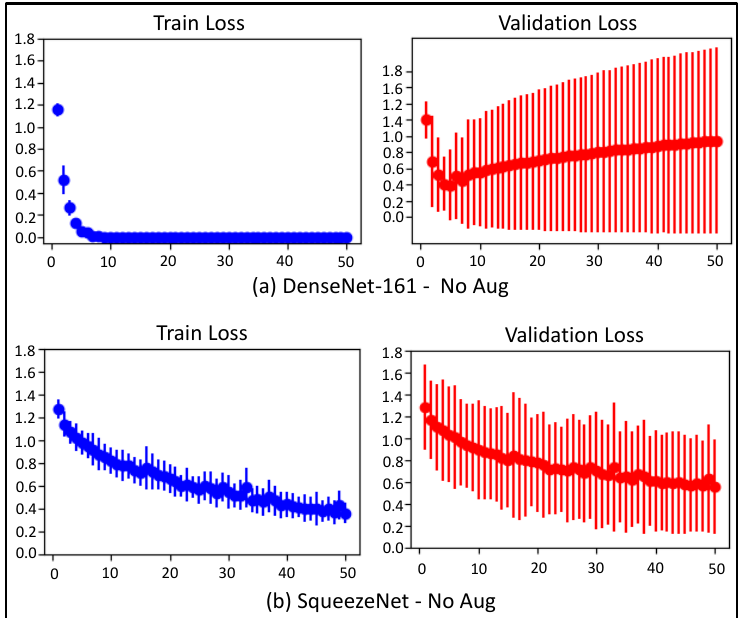
Figure 6. The train and validation loss for the fold = 0 of cross-validation. ( a ) DenseNet-161 with No Aug configuration; ( b ) SqueezeNet with No Aug configuration. The reported behavior of train and validation loss trends is comparable to that of the other